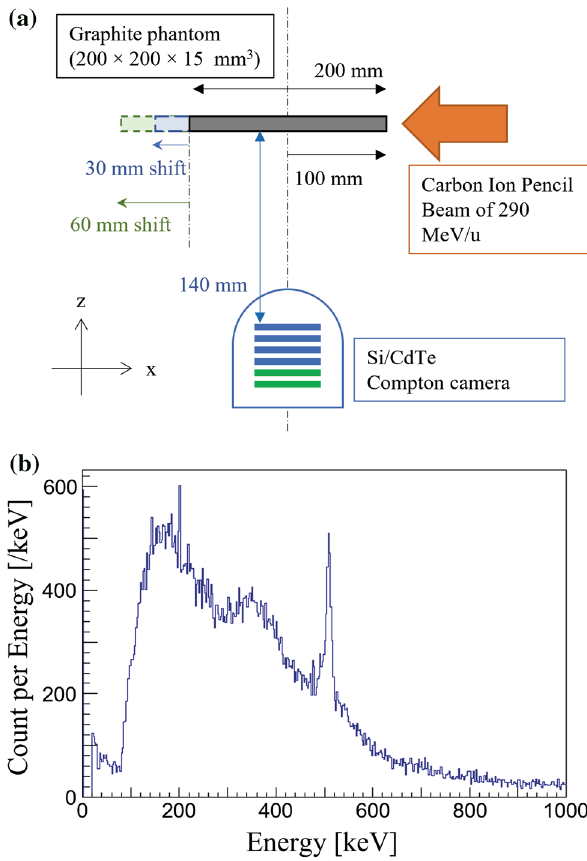
Figure 2. ( a ) Schematic illustration of the experimental setup. Graphite phantoms at the origin and those shifted by 30 mm and 60 mm were irradiated with a clinical carbon ion pencil beam of 290 MeV/u energy. ( b ) Energy spectrum measured by Compton camera under the beam-on condition in a graphite phantom placed at the origin (0